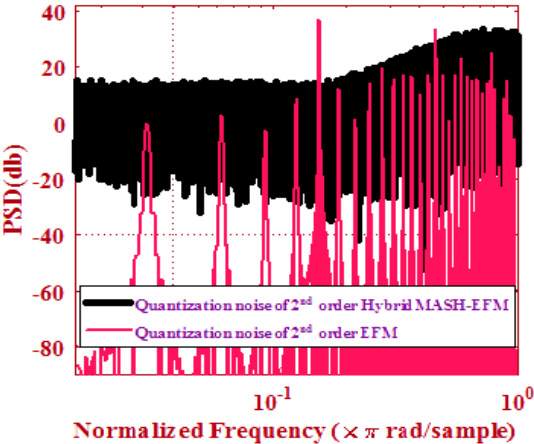
Figure 14. Comparison of the quantization noise of EFM and proposed architecture.